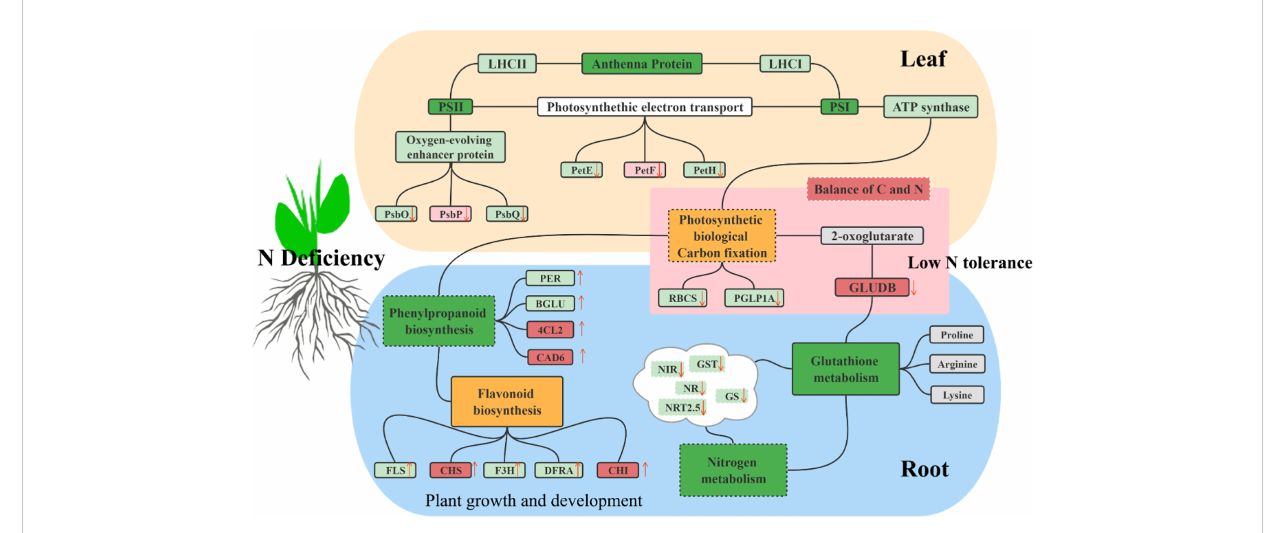
FIGURE 11 Modeling the response of sugar beet seedlings to low N